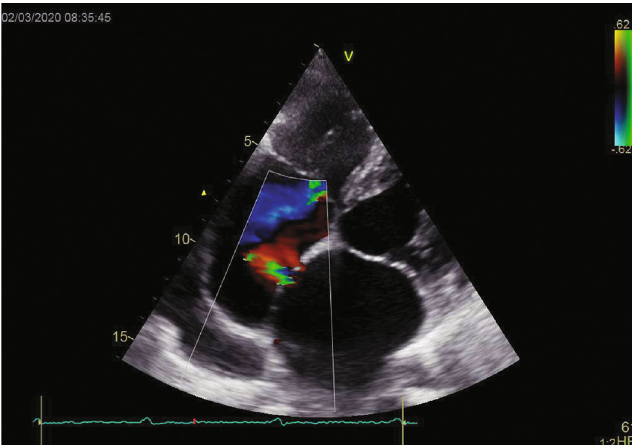
Figure 1: Atrial septal defect with left to right shunt. Both atria are enlarged. Tricuspid regurgitation jet is also visible.